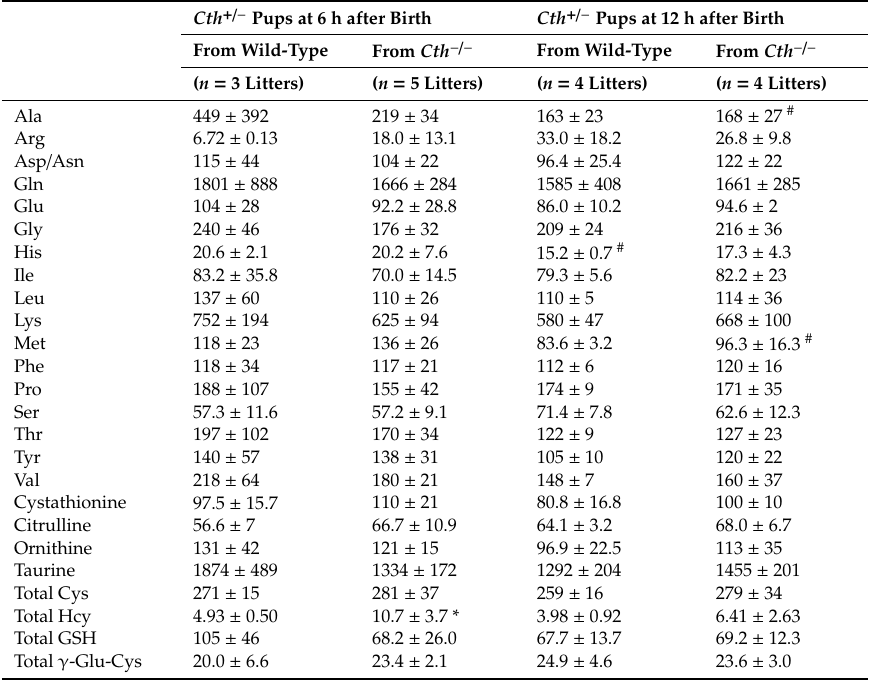
Table 2. Serum amino acid levels at 6 and 12 h after birth in Cth +/ − pups born to wild-type or Cth − / − dam